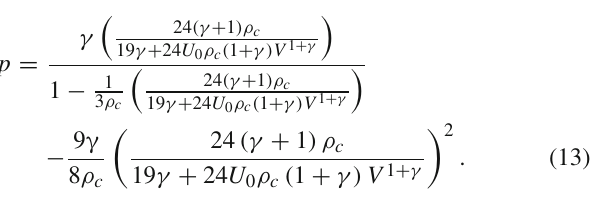
Fig. 3 Graph for pressure (p); w = − 2